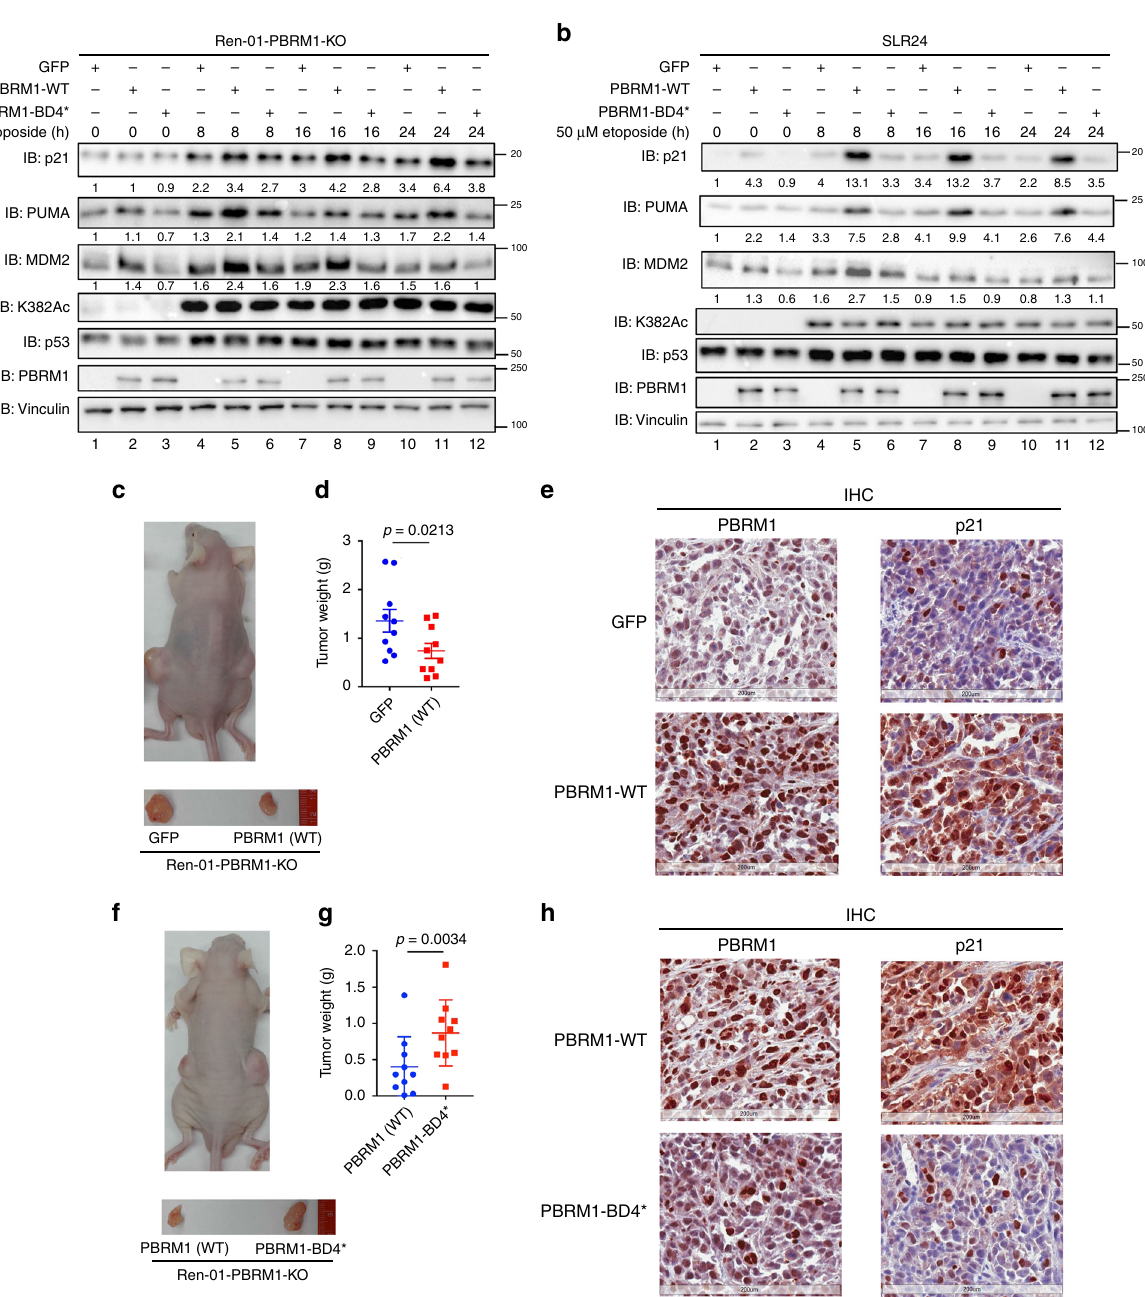
Fig. 6 Mutation of BD4 abolishes the tumor suppressive function of PBRM1. a , b GFP, wild-type or BD4* mutant PBRM1 were stably expressed in Ren-01 PBRM1 KO cells (combination of three clones) ( a ) or PBRM1-null SLR24 cells ( b ). Cells were treated with 50 μ M etoposide for the indicated times, and lysates were analyzed via immunoblots with indicated antibodies. The band intensity of indicated protein was measured with Bio-rad Image Lab 4.1, and the relative ratios were calculated over the signal intensity of Vinculin in the corresponding lanes. c – e . Nude mice xenograft analyses were performed with Ren- 01 PBRM1 KO cells expressing GFP (left fl ank) or PBRM1 (right fl ank). Representative photographs of a mouse ( c , top) and tumors ( c , bottom). Tumors were excised and weighed, and data are presented as mean ± SEM ( d ). p-values were calculated using the paired two-tailed Student ’ s t -test. Tumors were stained for PBRM1 and p21 expression via IHC ( e ). Scale bar: 200 μ m. f – h Nude mice xenograft analyses were performed with Ren-01 PBRM1 KO cells expressing wild-type PBRM1 (left fl ank) or the BD4* mutant PBRM1 (right fl ank). Tumors were excised and weighed, and data are presented as mean ± SEM ( g ). p -values were calculated using the paired two-tailed Student ’ s t -test. Representative photographs of a mouse ( f , top) and tumors ( f , bottom). Tumors were stained for PBRM1 and p21 expression via IHC analysis ( h ). Scale bar: 200 μ m. Source data are provided as a Source Data fi